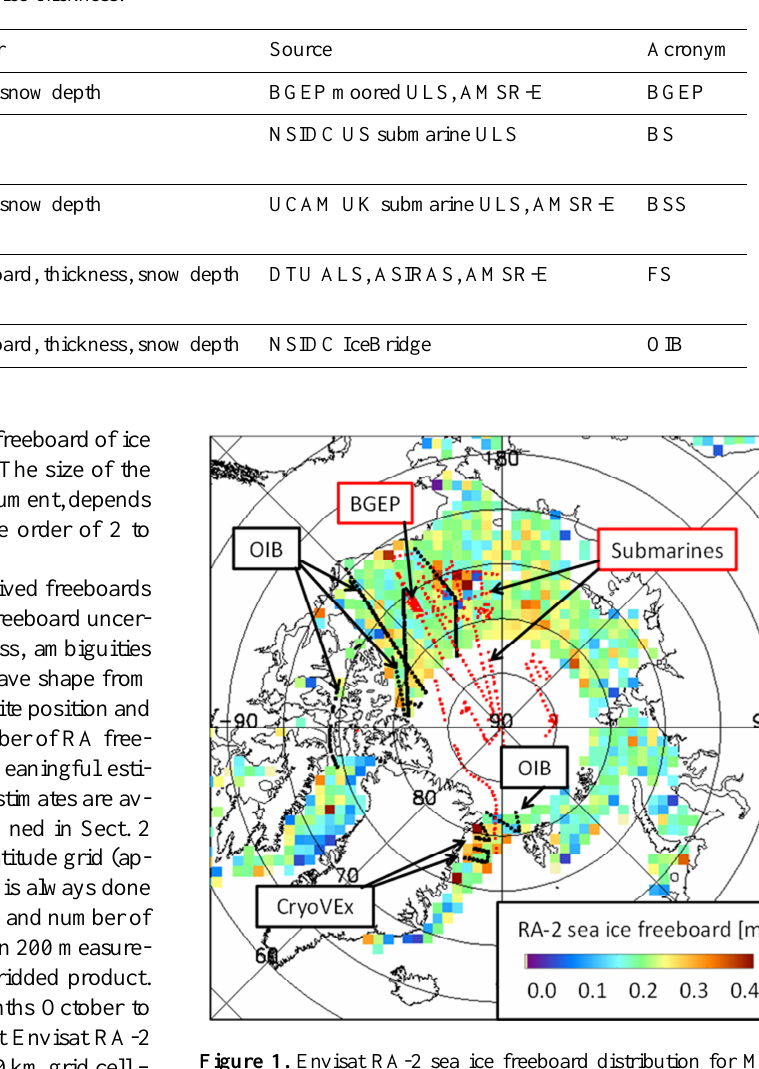
Figure 1. Envisat RA-2 sea ice freeboard distribution for March 2010 superposed with locations of campaigns used for our inter- comparison study: airborne campaigns (in black): CryoVEx, OIB; moored and submarine upward looking sonar (ULS) in red: BGEP, Submarines. Grid resolution is 100km. The white circular area around the pole indicates the region north of the 81.5 ◦ N parallel with no Envisat RA-2